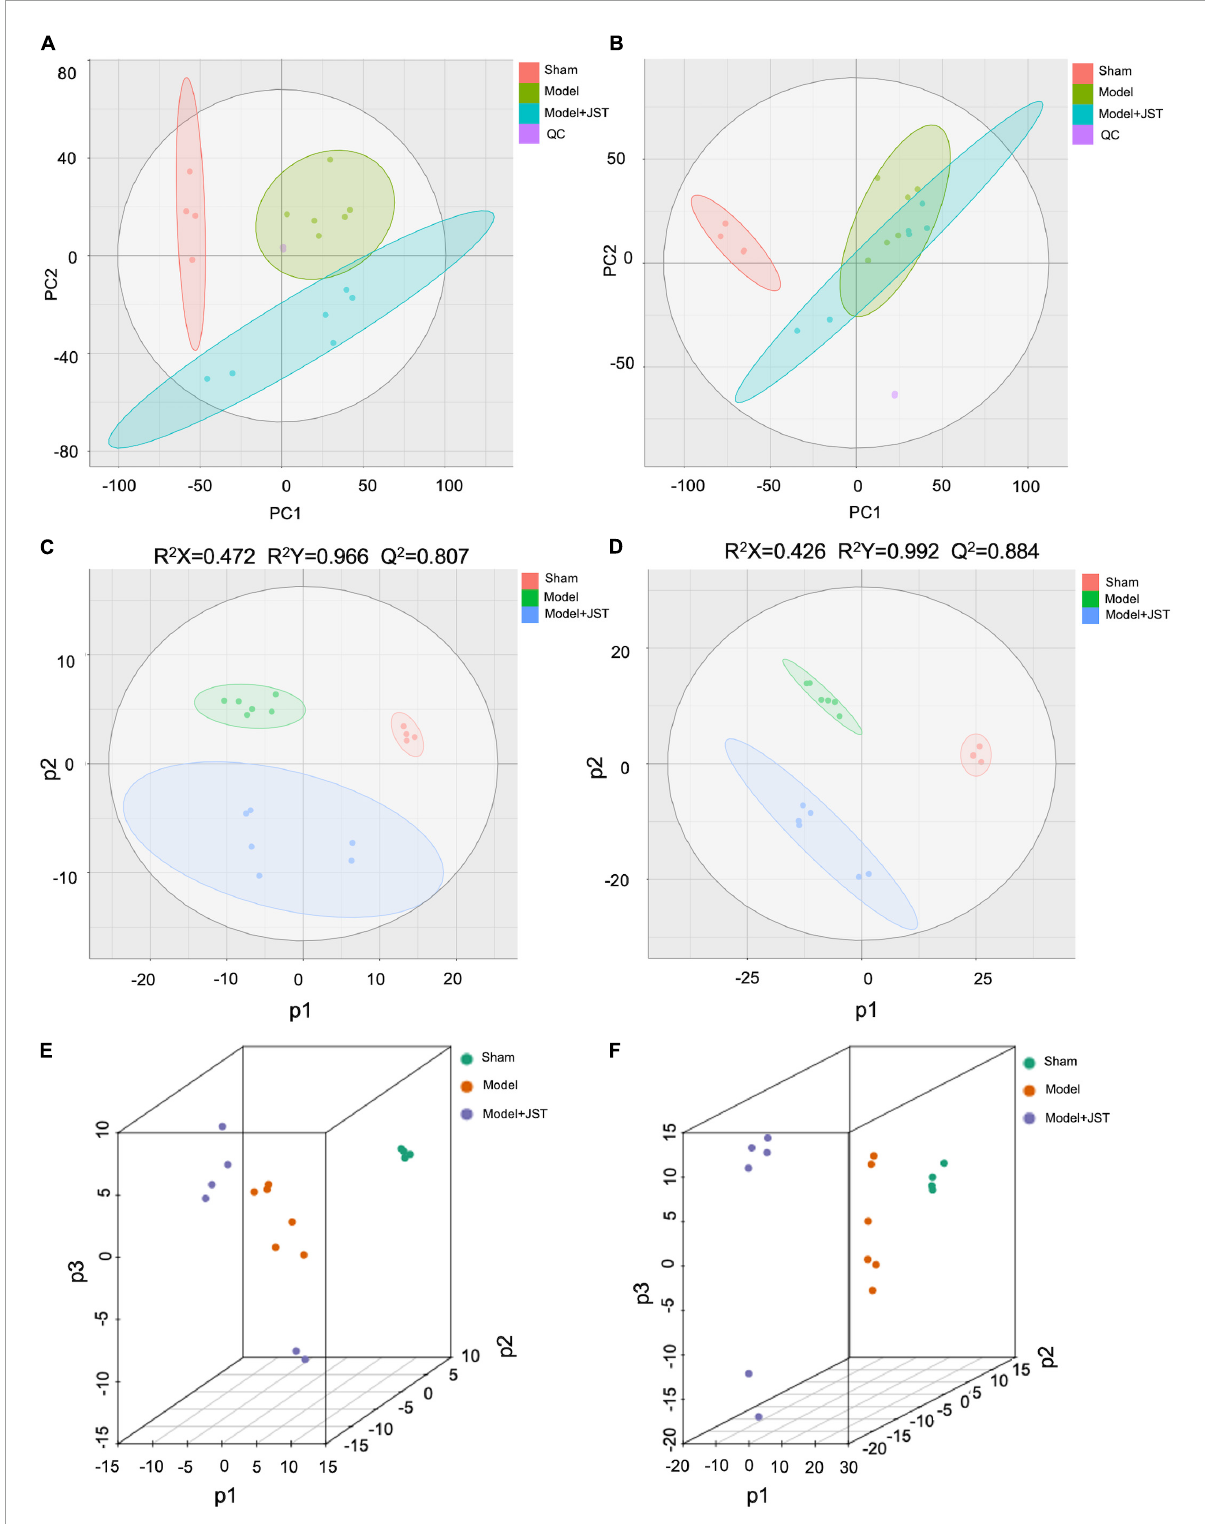
FIGURE4 Multivariate statistical analyses. Negative PCA score plots with QC (A) ; positive PCA score plots with QC (B) ; negative PLS-DA score plots (C) ; positive PLS-DA spots (D) ; negative PLS-DA (3D) spots (E) ; positive PLS-DA (3D) spots (F)